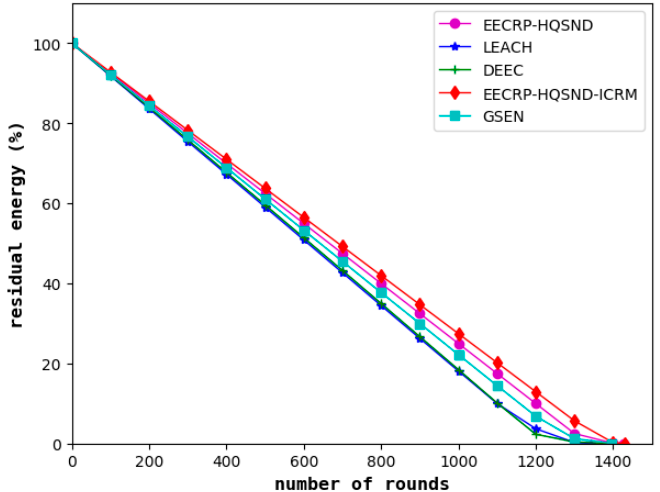
Figure 19. The network residual energy varies with the iteration round.